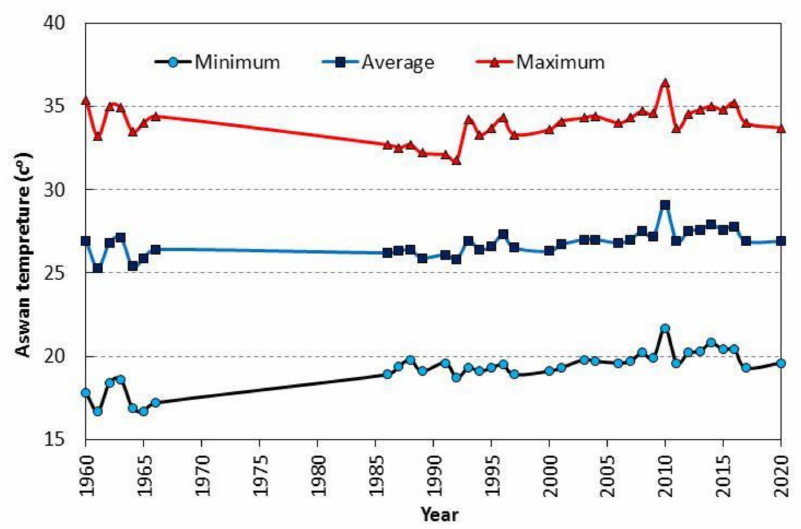
Figure 4. Temperature values with different